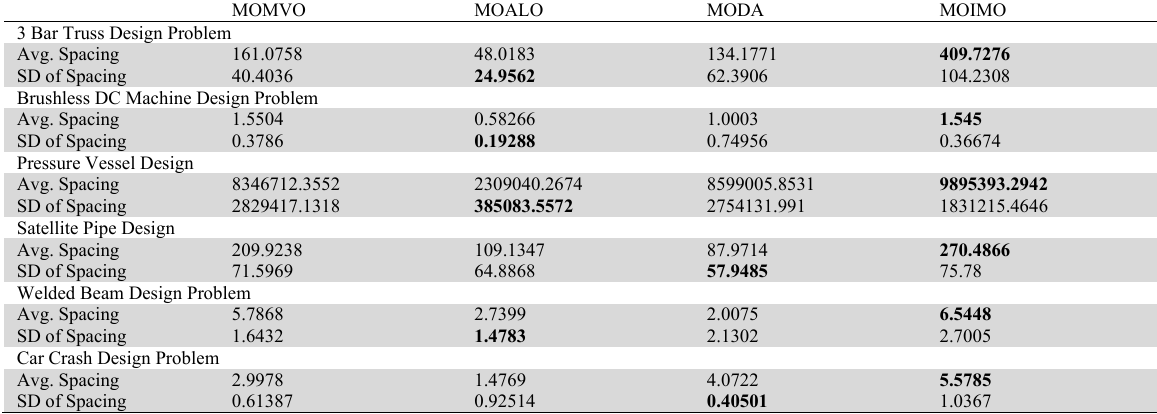
Fig. 5 presents the overall performance comparison of all the algorithms in terms of best values of performance indicators and its (their) standard deviation over 10 independent runs. MOIMO obtains the best value of average GD and IGD for 8 and 13 times, respectively. GD and IGD are indicators of proximity to the true Pareto front. For 17 instances, MOIMO obtains the best value of spread presenting better coverage and convergence in all algorithms. MoS reflects the coverage of solutions. For 14 cases, MOIMO gets the best values of MoS. Except for MoS, for all three performance indicators, MOIMO presents minimum standard deviation proving the consistency of results. Thus, we can conclude that MOIMO provides the best results across all the algorithms for the majority of performance indicators.